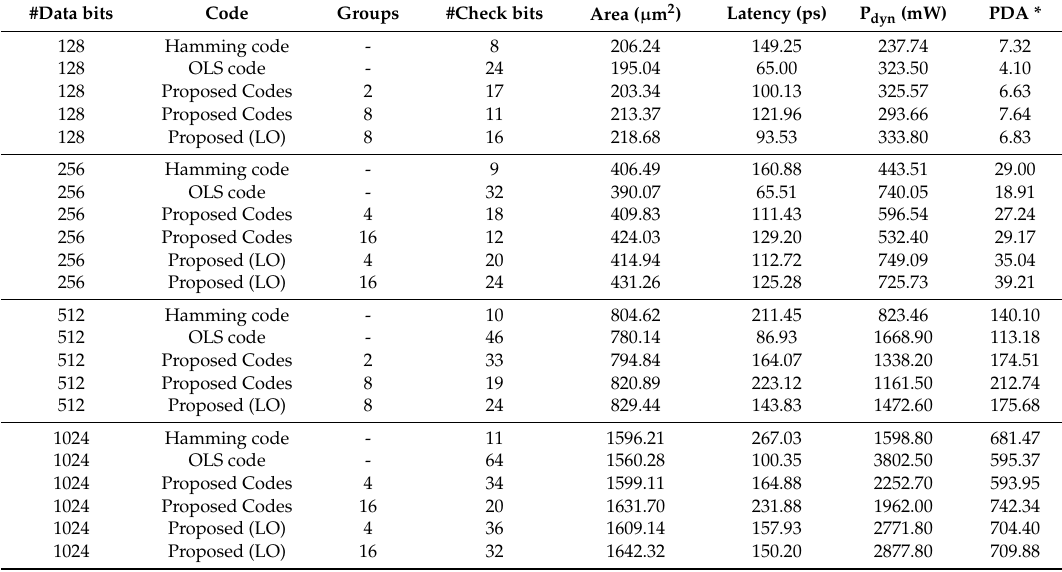
Figure 12. Comparison of memory overhead-delay product of decoder between OLS codes and proposed codes. From both Table 1 and Table 2, it can be seen that OLS codes have an overall good performance in terms of latency, area and power consumption, but OLS codes do suffer from high memory overhead. The proposed codes focus on reducing the high memory overhead of OLS codes while still maintaining an adequate decoder latency to enable good performance. Thus, a memory-overhead delay product (MODP) metric is used to make this comparison. Figure 12 shows the MODP comparison normalized to OLS codes (i.e., OLS codes will have a MODP of 1) for both the unoptimized proposal and latency optimized proposal. Since there are multiple possibilities of the number of groups for the proposed codes, the best MODP value is plotted against OLS codes. It can be seen that the proposed codes are able to achieve much better MODP compared to OLS codes, with the MODP as low as 0.33 times OLS codes. This is possible due to the low memory overhead of the proposed codes. The key takeaway from this figure is that the proposed codes are able to achieve much lower memory overhead without a corresponding significant rise in decoding latency.